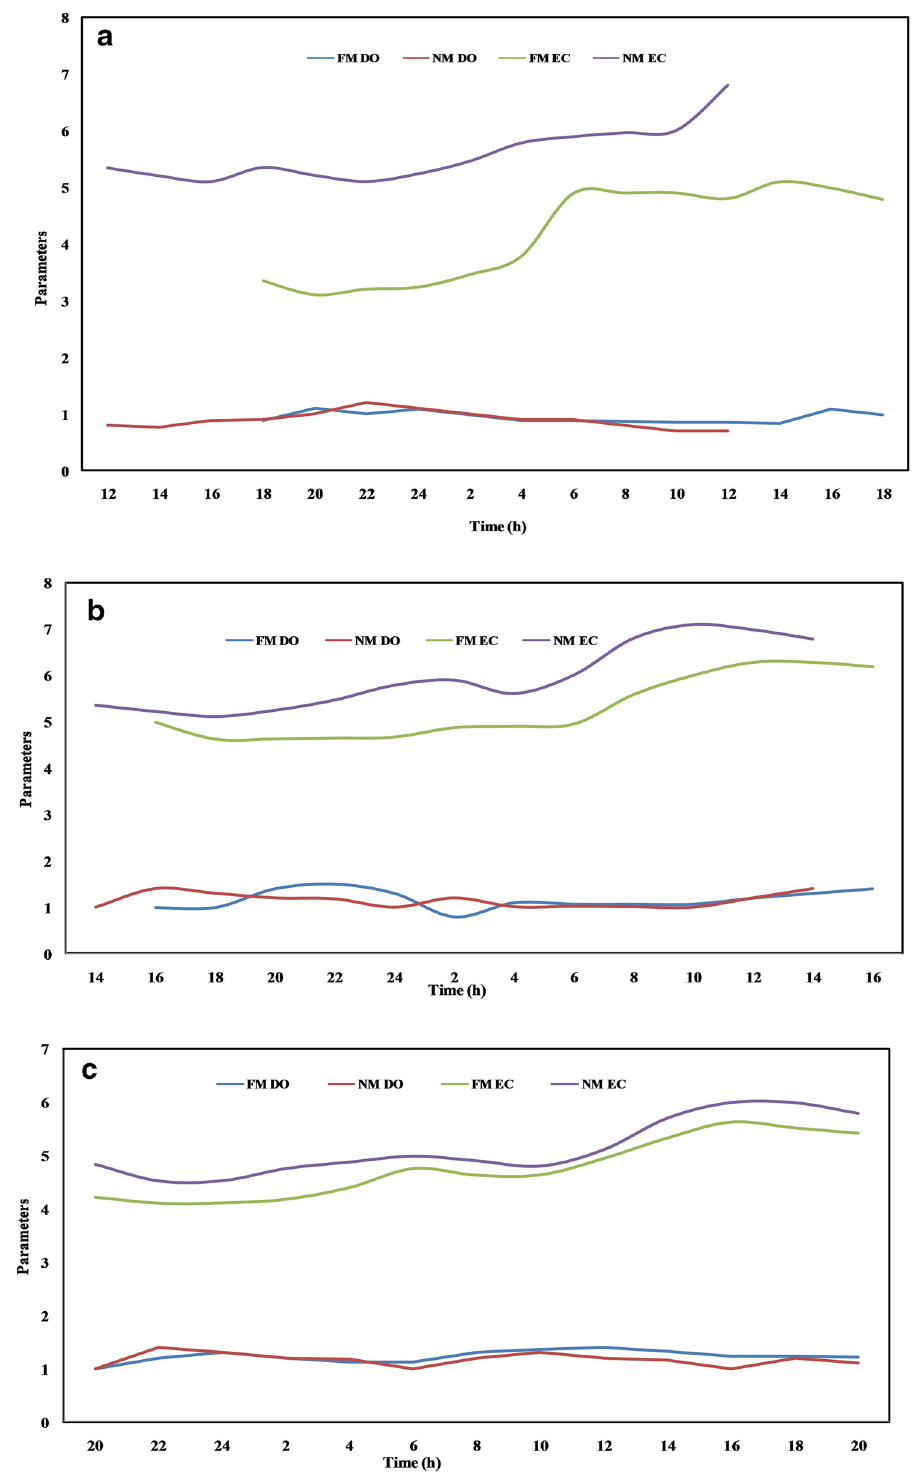
Fig. 9 Tidal influence on Devanampatnam, Rajapettai and Tiyagavalli during FM and NM [DO (mg/l), EC (mS), water table and tide